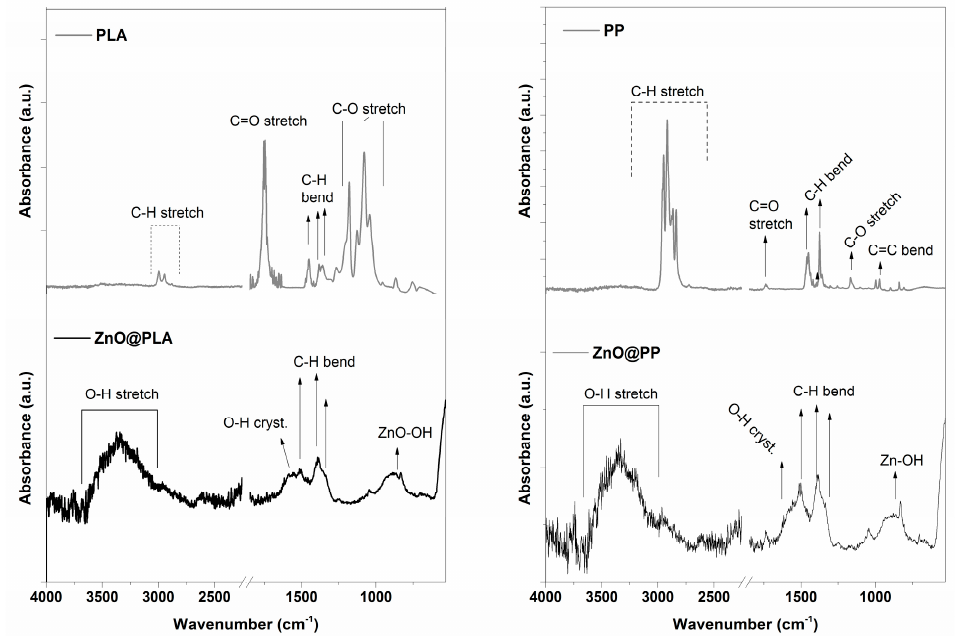
Figure 5. ATR-IR spectra of PLA and PP supports, with or without the presence of the ZnO coating.